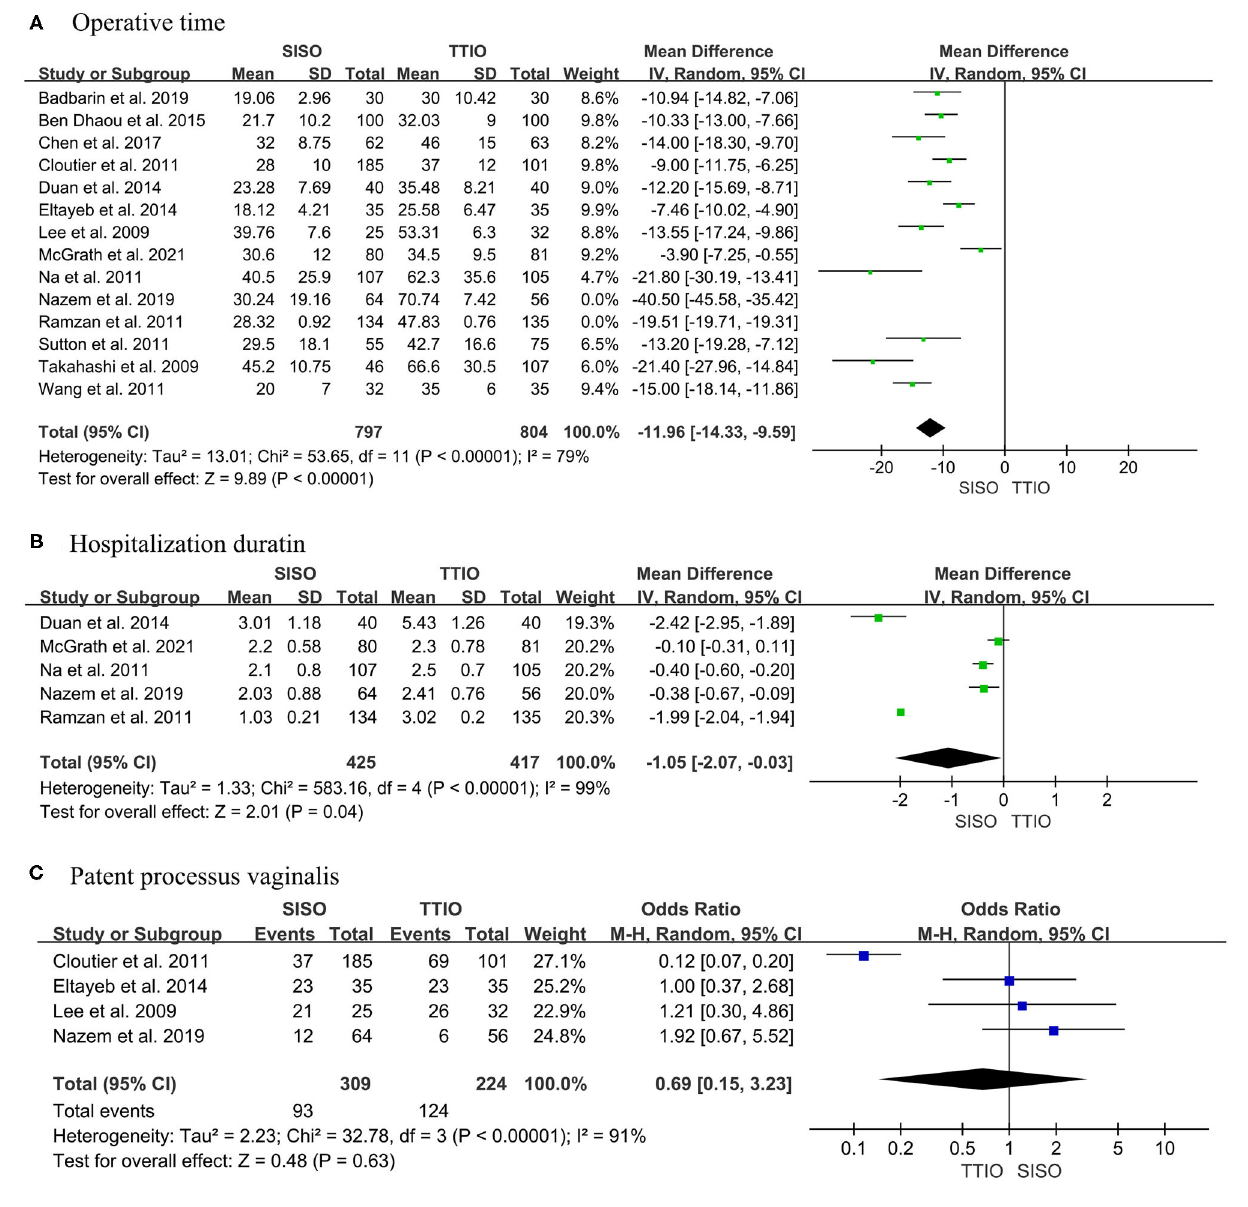
Frontiers in Pediatrics |